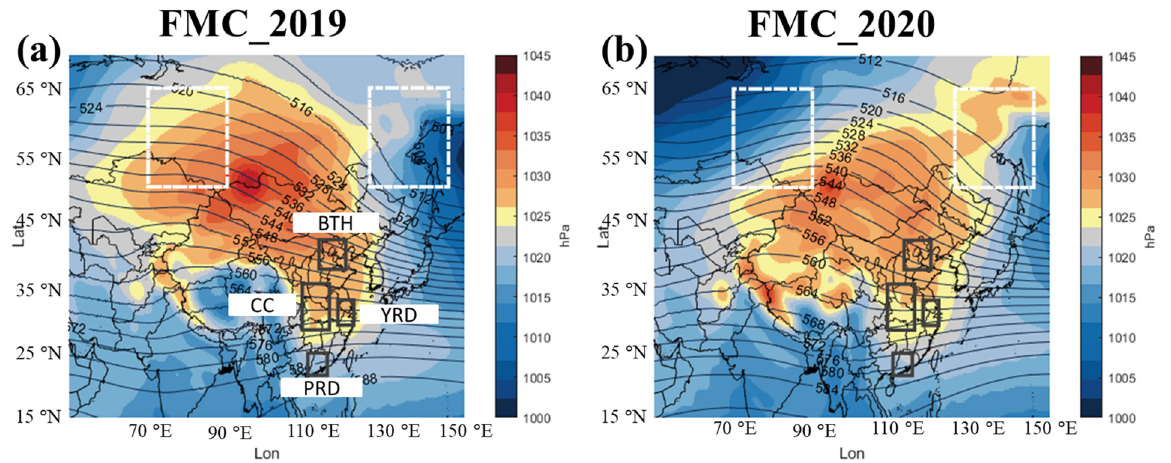
weakened one by one from the BTH to the PRD. Figure 6. Monthly average geopotential height at 500 hPa and sea-level pressure over Eurasia. ( a ) FMC_2019; ( b ) FMC_2020. The white boxes are meridional circulation regions. The meridional circulation index (MCI) is used to represent the intensity of atmo- spheric circulation [91,92]. The higher value of MCI means that it is easier for cold air from the north to flow to the south, and the exchange of airflow between north and south is enhanced, which is conducive to the diffusion of aerosol pollution. In this paper, we choose two regions for calculating MCI (50–65 ◦ N, 70–90 ◦ E and 50–65 ◦ N, 126–146 ◦ E, white boxes